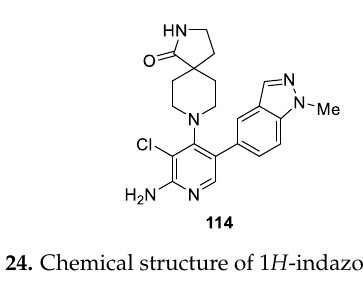
Figure 25. Chemical structures of 1 H -indazole amide derivatives 115 – 118. Figure 26. Chemical structure of 3(S)-thiomethyl pyrrolidine-1 H -indazole derivative 119. Qian et al. [71] synthesized a novel series of 1 H -indazole derivatives with disubstituent groups at both 4-position and 6-position. The authors carried out IDO1 inhibition assay using three inhibitory concentrations. The results revealed that some compounds displayed remarkable IDO1 inhibitory activities. Among all of the tested coumponds, compound 120 exhibited the most IDO1 inhibitory